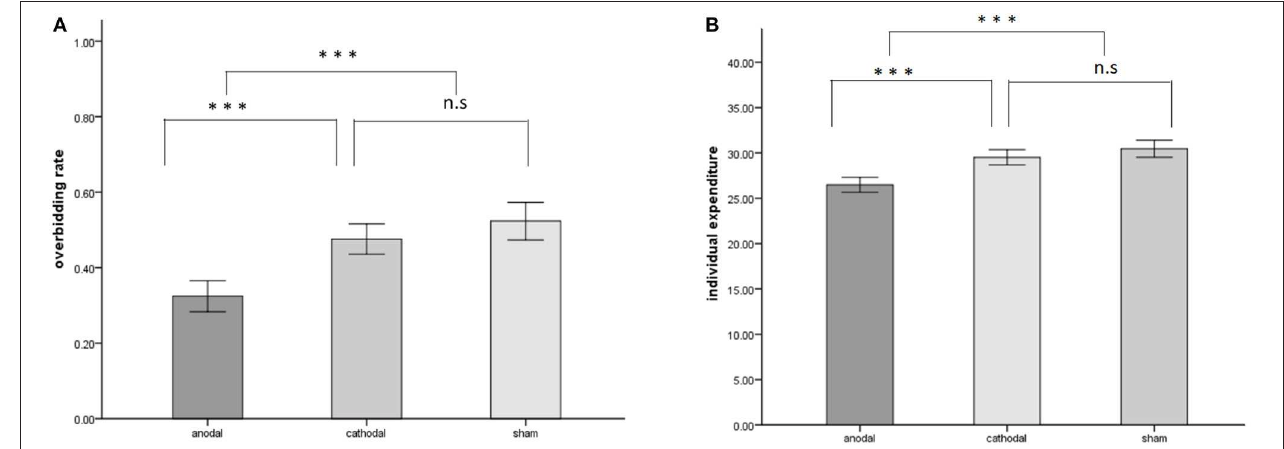
FIGURE 3 | Stimulation effects (anodal/cathodal vs. sham) on the overbidding rate (A) and individual expenditures (B) across all periods. A significant main effect of both overbidding rate and individual expenditures was observed, driven by the difference between the anodal condition and other conditions. Error bars depict SD of the mean, *** p < 0.001.